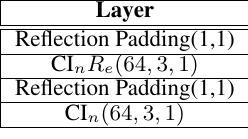
Table 2. Generator’s ResNet block.